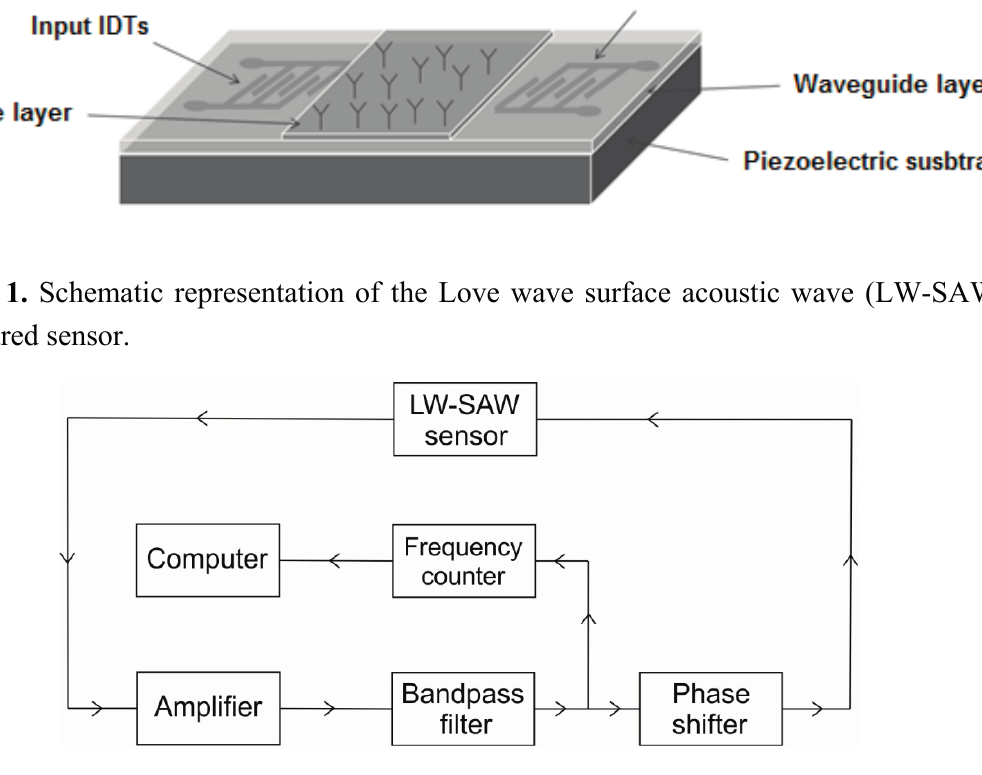
Figure 2. Experimental setup used to characterize the LW-SAW